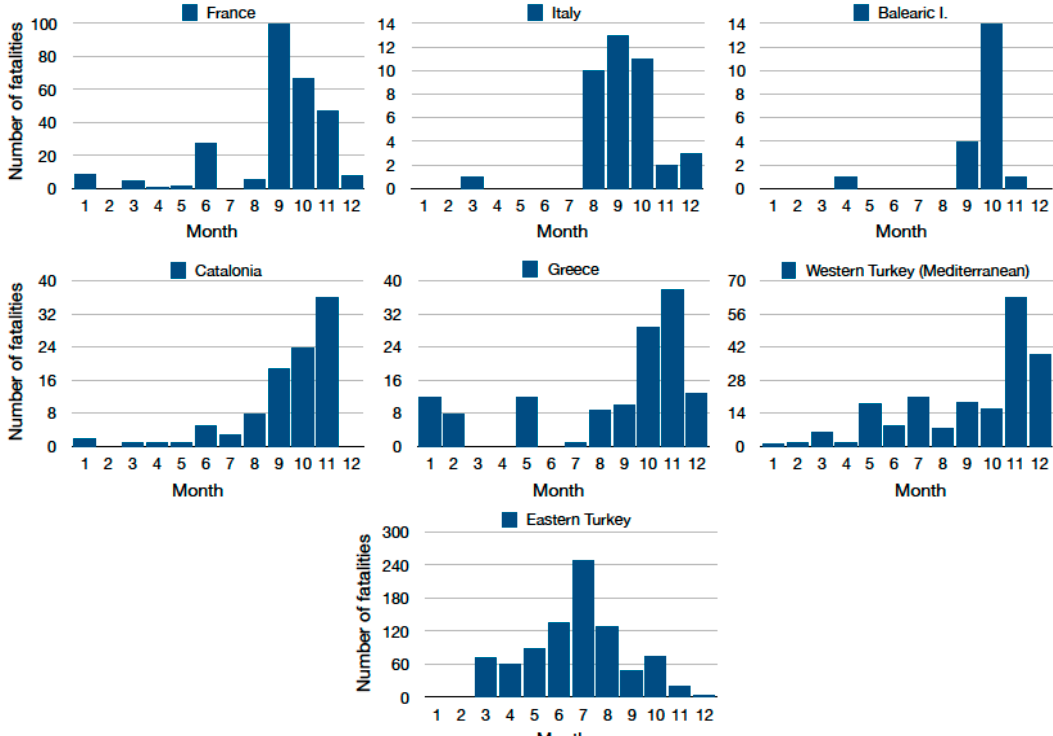
Figure 11. Monthly distribution of flood fatalities per country. Table 3. Deadliest month per region.